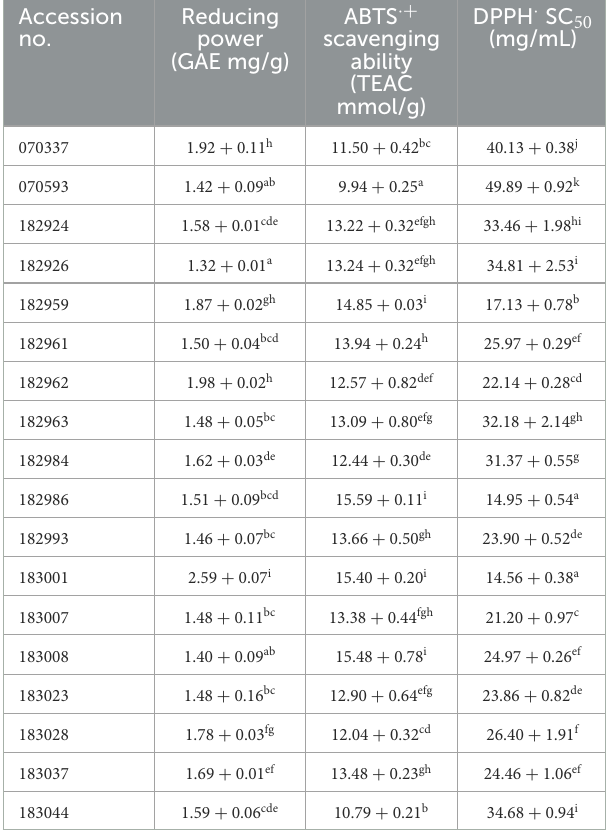
TABLE 3 Antioxidant activity of 18 elite yellow-fleshed cassava genotypes. Accession